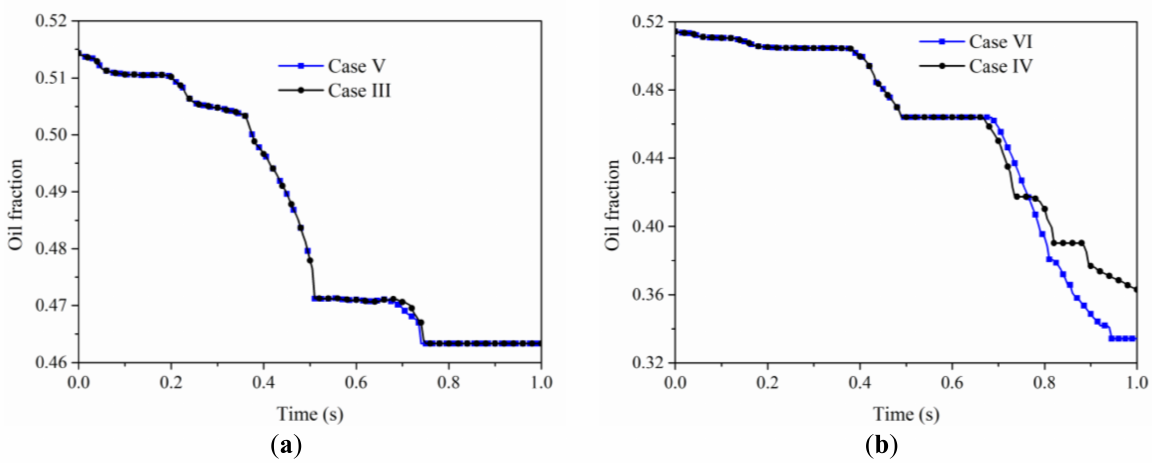
Figure 21. Comparison of oil saturation variation with time between slug injection and alternate injection: ( a ) small particles, ( b ) large